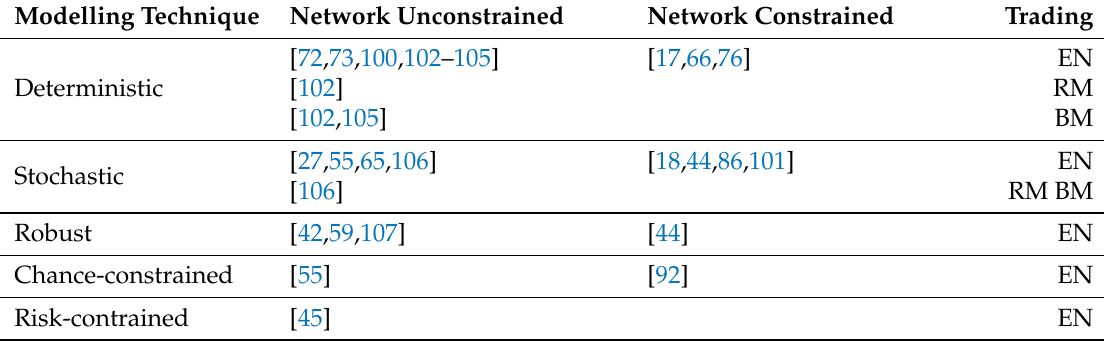
Table 3. Literature survey on the strategic ESS operating at the transmission level. (Abbreviations: EN, energy only; RM, reserve market; BM, balancing